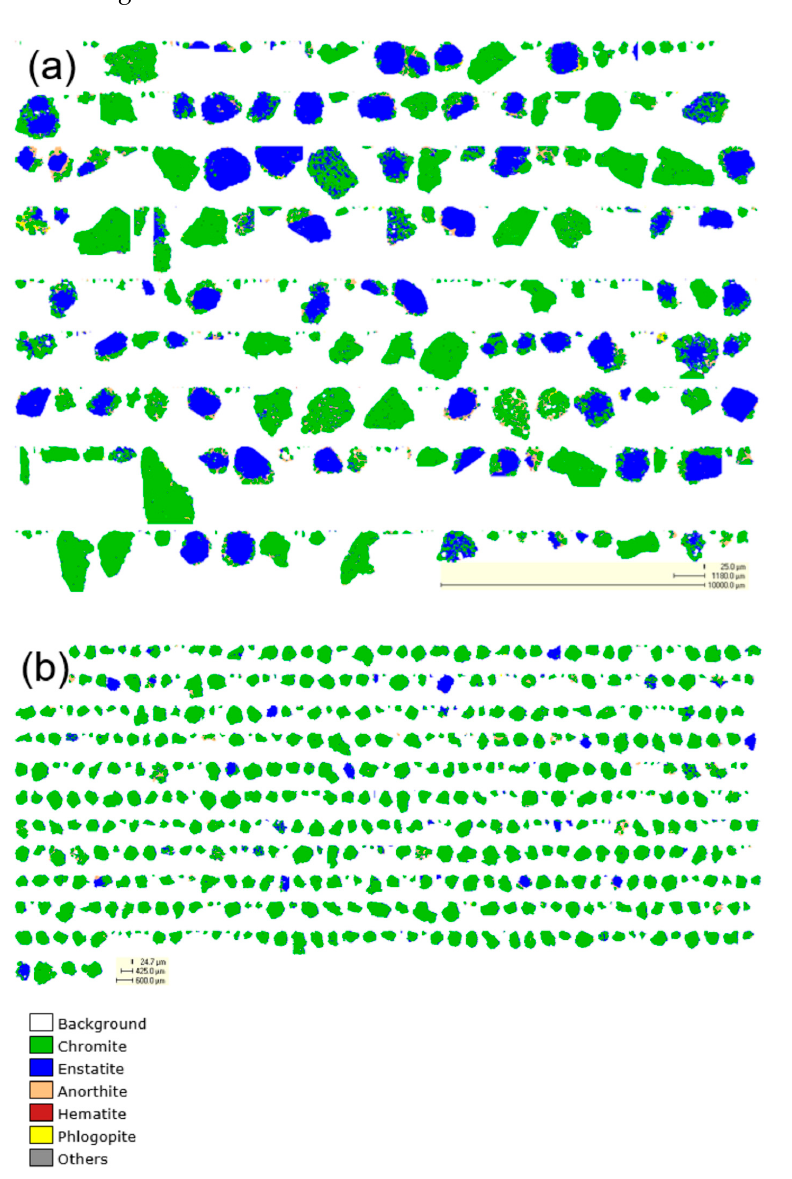
Figure 5. Particle mineral map from ( a ) the − 2 mm bulk sample and ( b ) the − 600 +425 μ m fraction.